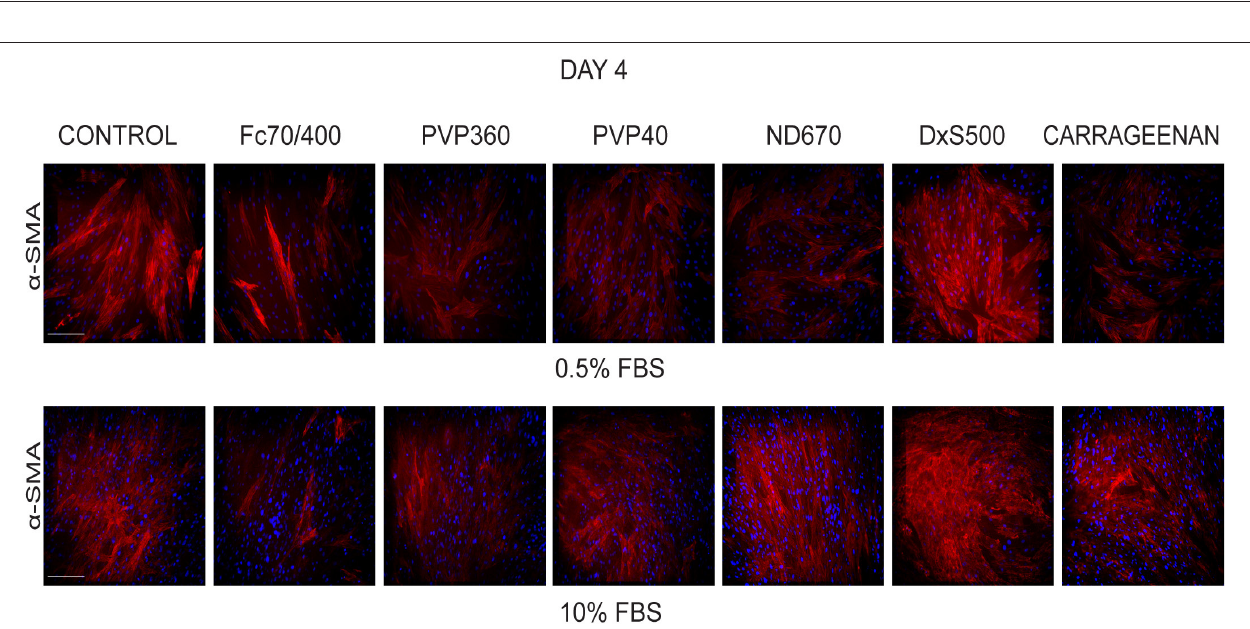
FIGURE 3 | Effect of serum concentration on myofibroblast formation. Immunofluorescence staining of α -smooth muscle actin in human dermal fibroblasts ( n = 2) after 96h in the presence of TGF β 1 in DMEM containing 0.5 and 10% of FBS and macromolecular crowders Fc70/400 mixture, PVP360, PVP40, ND670, DxS500, and CR. Showing 1 FVO; DAPI, α -SMA; magnification 10x, scale bars 200 µ m.